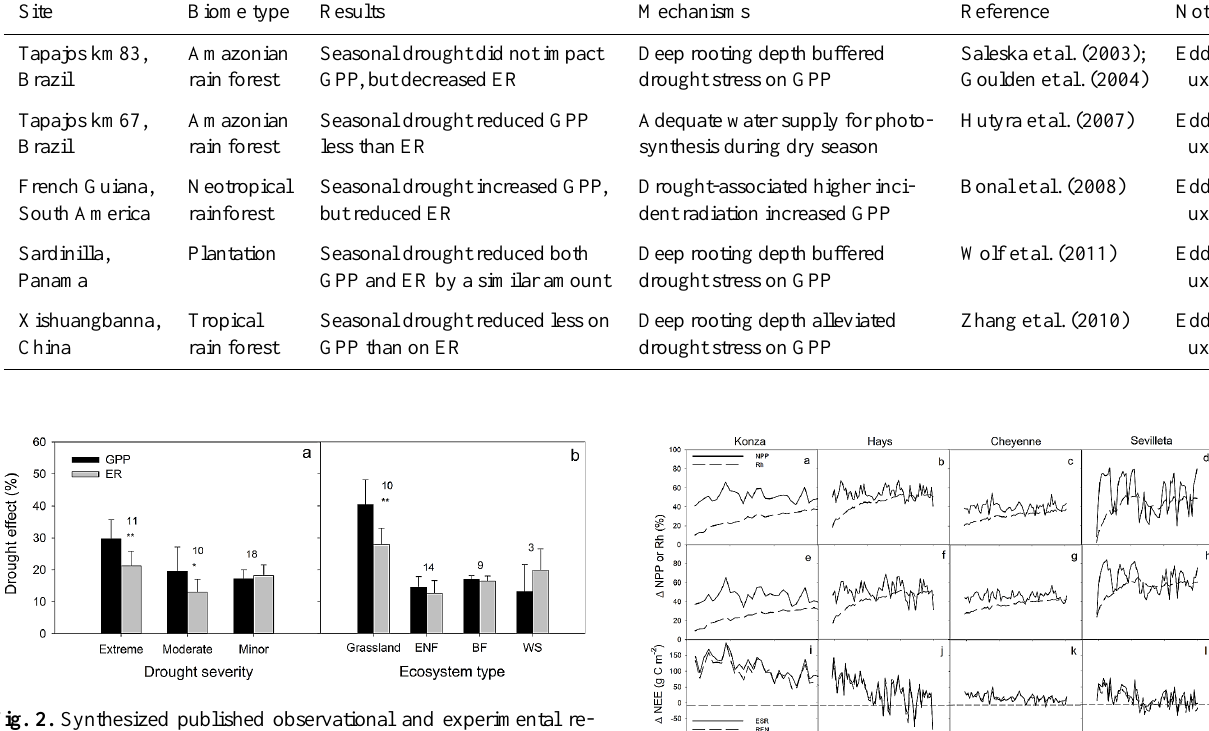
Fig. 2. Synthesized published observational and experimental re- sults on sensitivity of gross primary production (GPP) and ecosys- tem respiration (ER) to drought severity (a) and to drought in dif- ferent ecosystem types (b) . The ecosystems were divided into grass- land, evergreen needle-leaf forest (ENF), broad-leaf forest (BF) and woody savannahs (WS). One open shrubland, one oak woodland and one pine woodland were not included in the data analysis due to limited sample size. Numbers represent the number of studies included, ∗∗ represents significant ( P < 0 . 05) difference and ∗ rep- resents marginally significant difference ( P < 0 . 1).